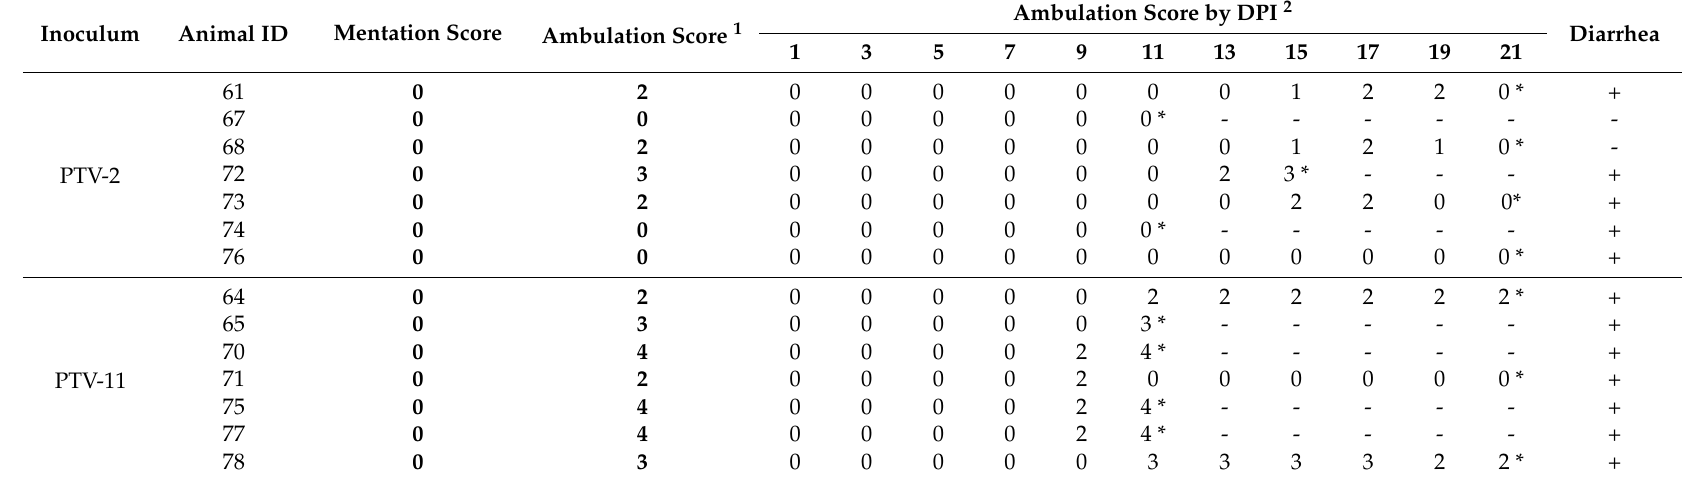
Table 4. Clinical evaluation by